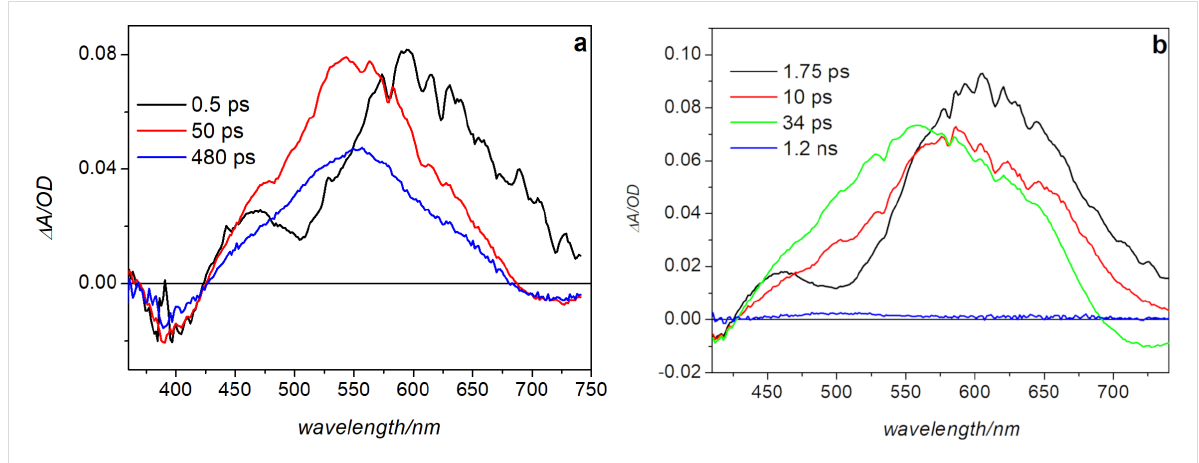
Figure 5: EADS obtained by global fit of the transient data recorded in a) acetonitrile and b) methanol upon excitation at 400 nm.